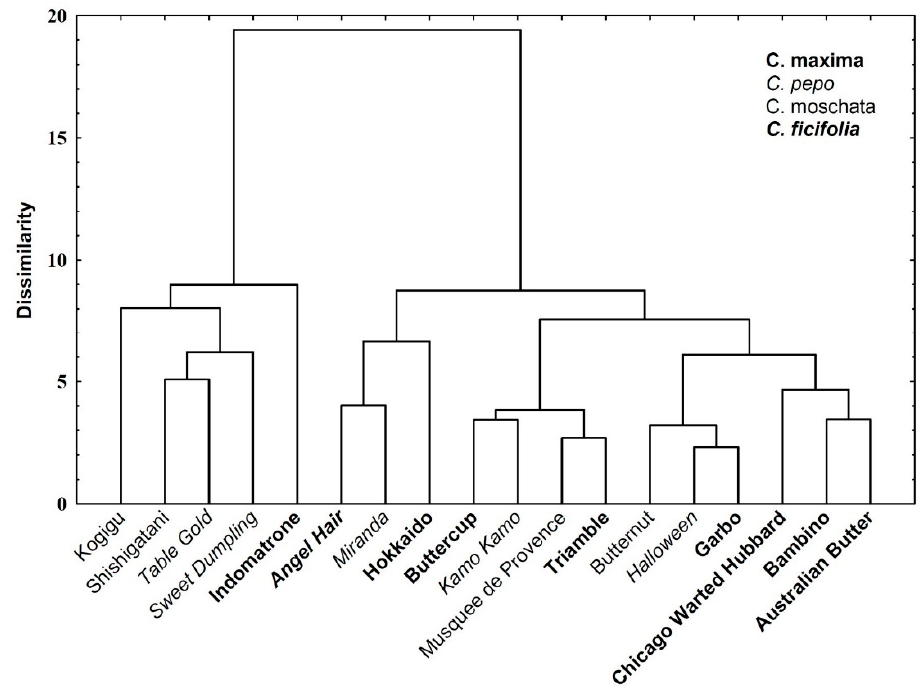
Figure 1. Dendrogram grouping 18 Cucurbita cultivars based on quality parameters including: the content of total and selected phenolic compounds, antioxidant capacity, the content of mineral elements, amino acids, and soluble sugars in the pulp. Dissimilarity was measured as Euclidean distance and the agglomeration was made with the use of Ward’s method.